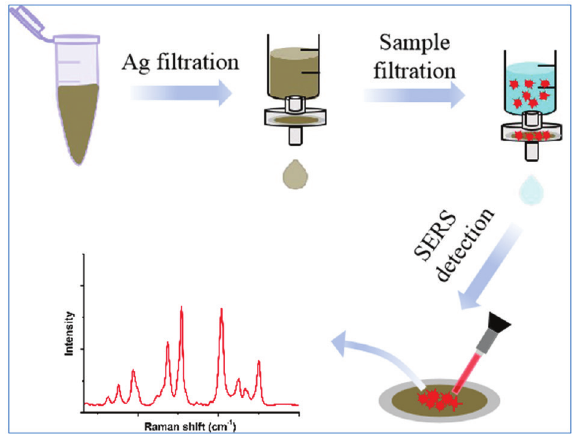
Figure 1: Schematic the pioneer work from Ian’s group on the fabrication, enrichment and SERS detection of filter-based substrate prepared by simple syringe filtering